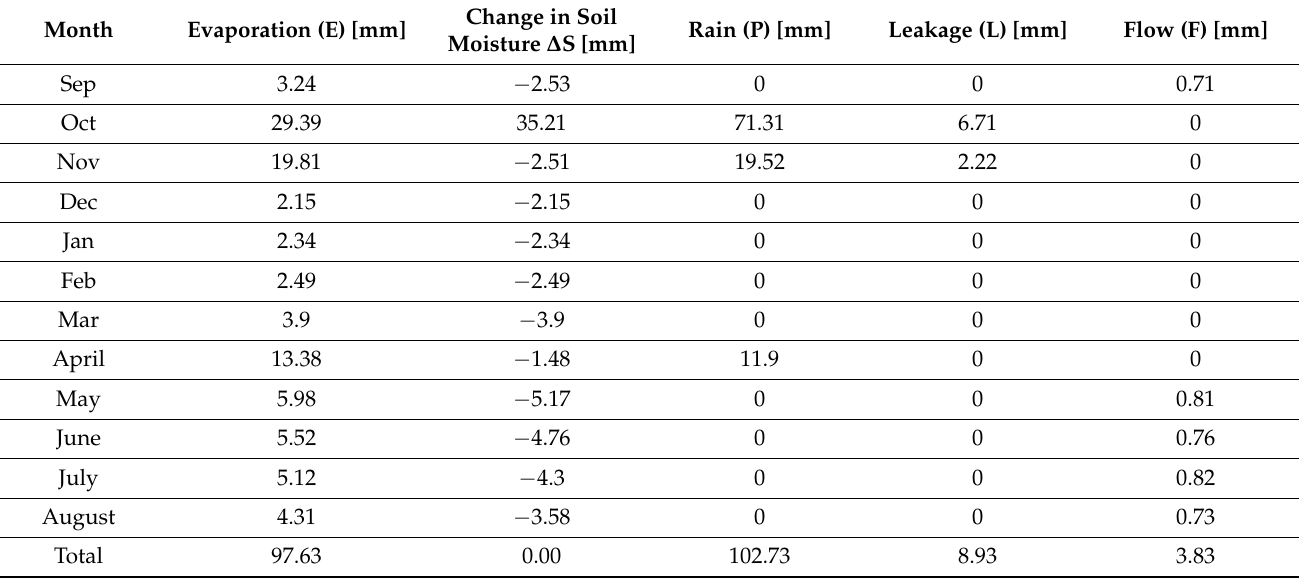
Table 4. Summary of main results for the hydrological year